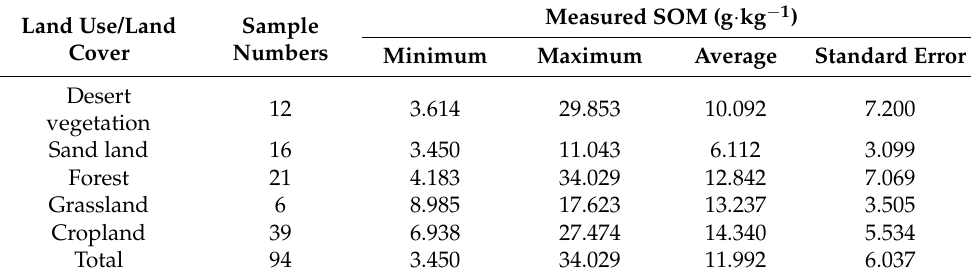
Table 1. Measured SOM of 94 soil